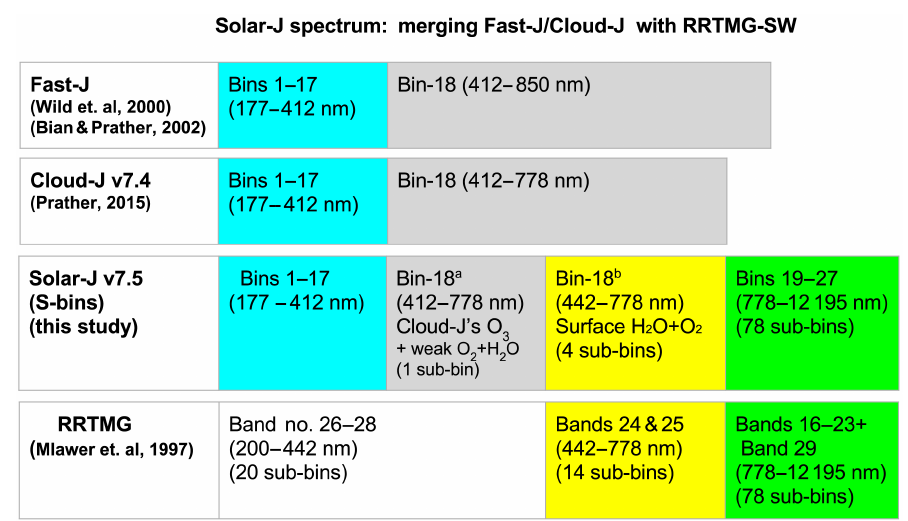
Figure 1. Solar-J extends Cloud-J’s solar wavelength bands by combining and modifying RRTMG-SW’s bands 24 and 25 (442–778nm) and adopts all RRTMG’s bands longwards of 778nm (see text for